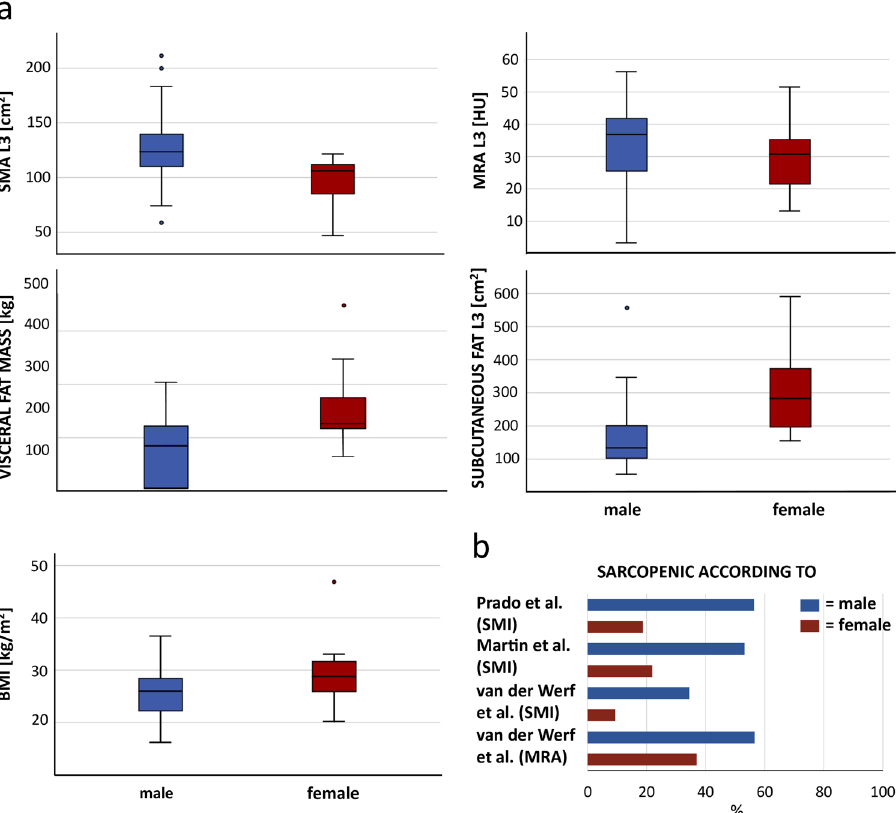
Figure 2. Sex-specific distribution of fat and muscle parameters at L3 and percentages of sarcopenic patients. Distribution of the skeletal muscle area (SMA), muscle radiodensity attenuation (MRA), and the subcutaneous fat area at the level of the third lumbar vertebra (L3), the visceral fat mass, and the body mass index (BMI) in men (blue) and women (red) ( a ). Male patients showed a lower mean BMI, less subcutaneous fat, and a lower visceral fat mass. The SMA and MRA were higher in men, however, according to all employed sarcopenia cut-off values, men were more often classified as sarcopenic than women ( b